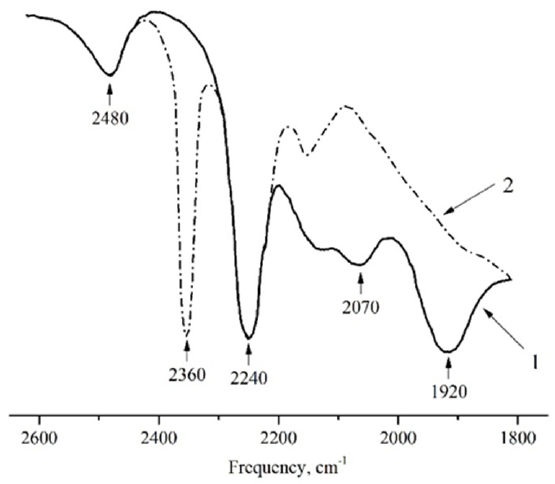
Figure 3. IR spectra of NO adsorbed at 20 °C and 10 Torr on Ca-FAU (Y) zeolite (1) followed by adsorption of CH 4 (20 °C, 10 Torr) (2).